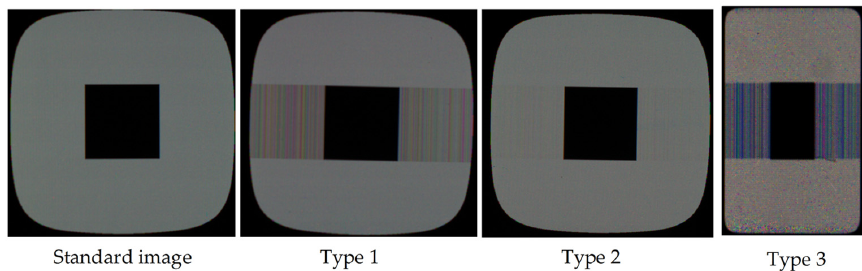
Figure 3. Different types of input images.